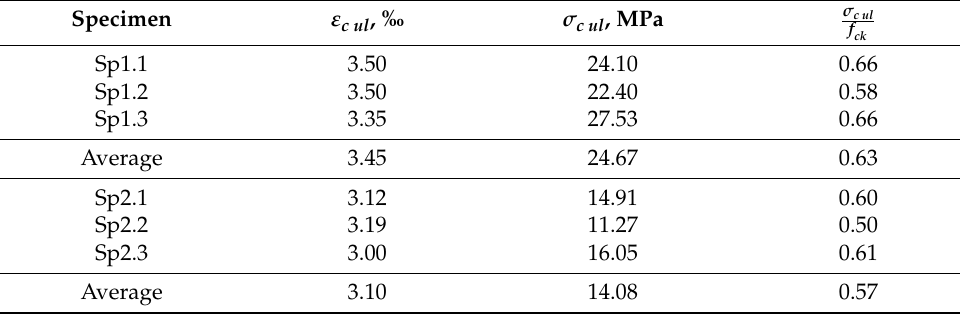
Table 3. Experimental values of the σ c − ε c diagram descending branch